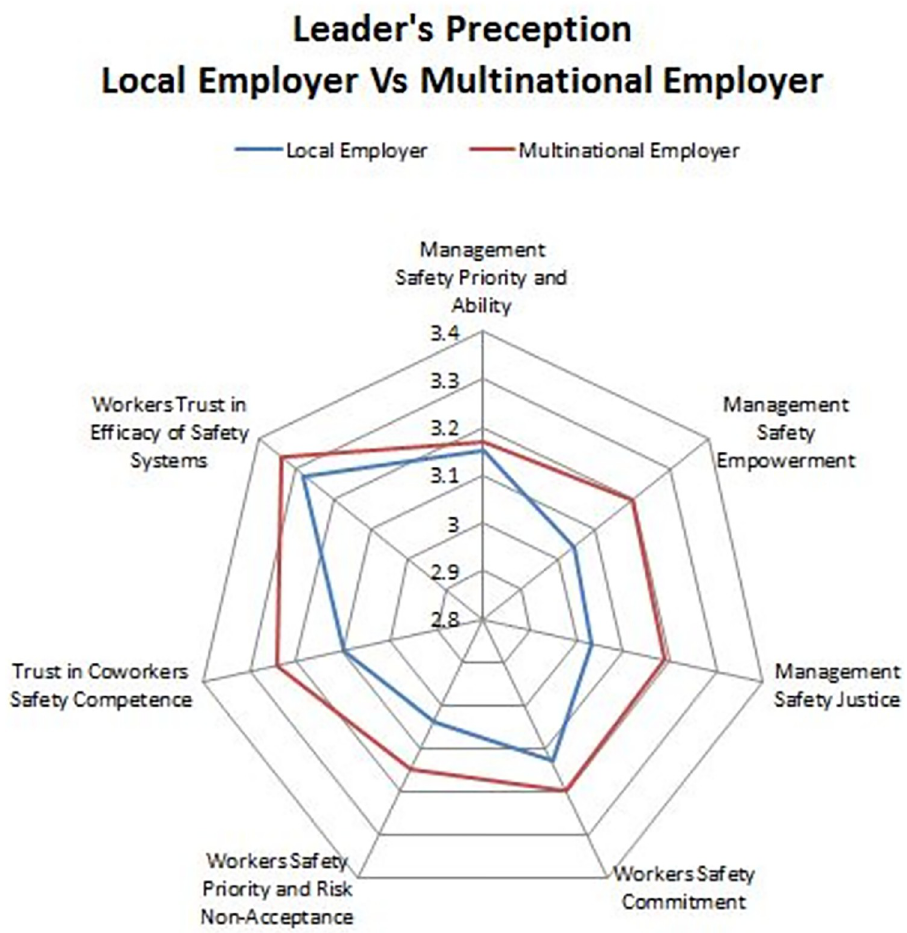
Fig 2. Leader’s perception on safety climate in both MNCs &